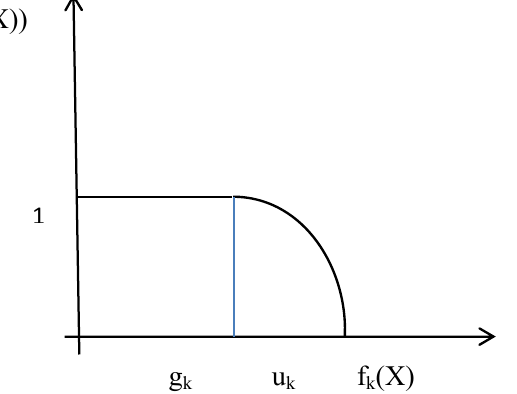
Fig. 1. Membership function for minimization-type